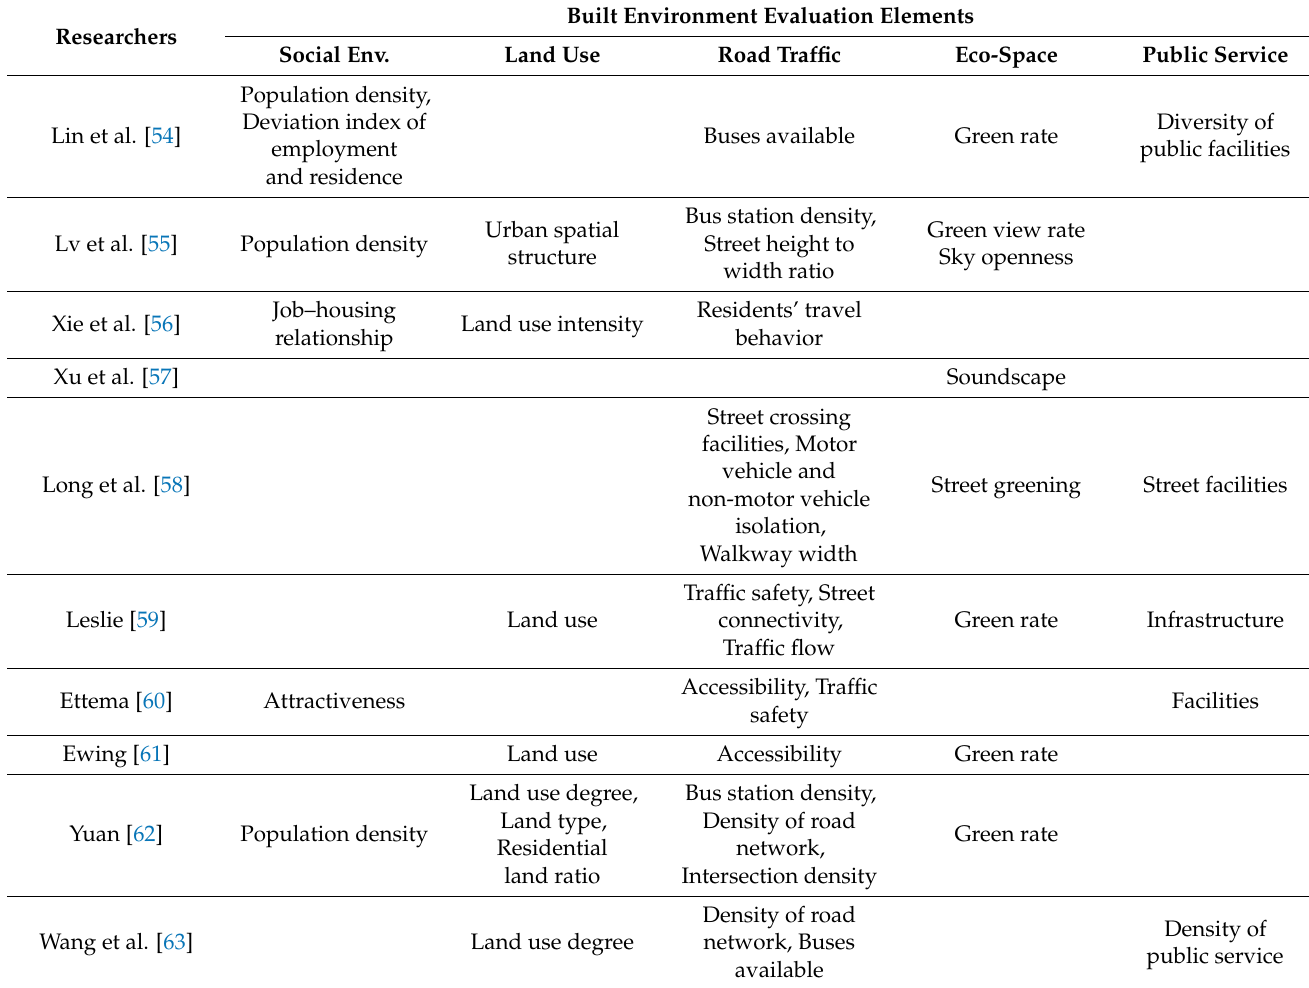
Table 1. Summary of previous